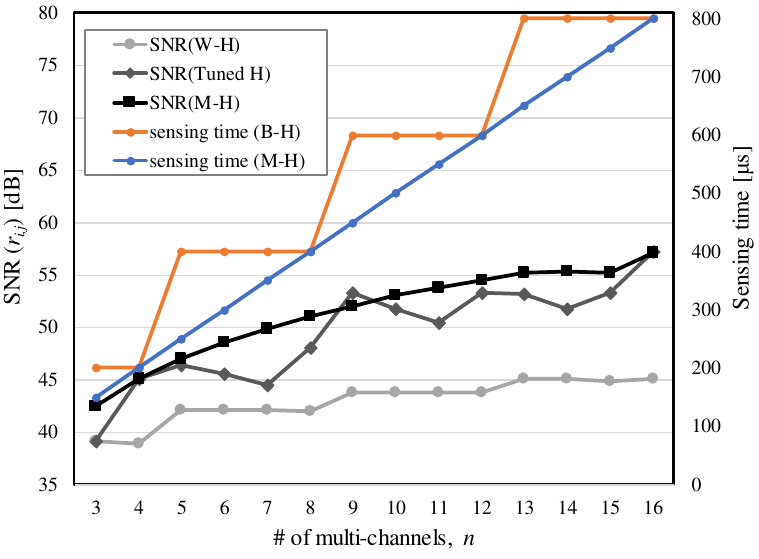
Figure 6. Comparison of signal acquisition properties for the identical m between B-H [1,10,12–14] and proposed M-H matrices where α V TX = 350 mV and z x = 7.7